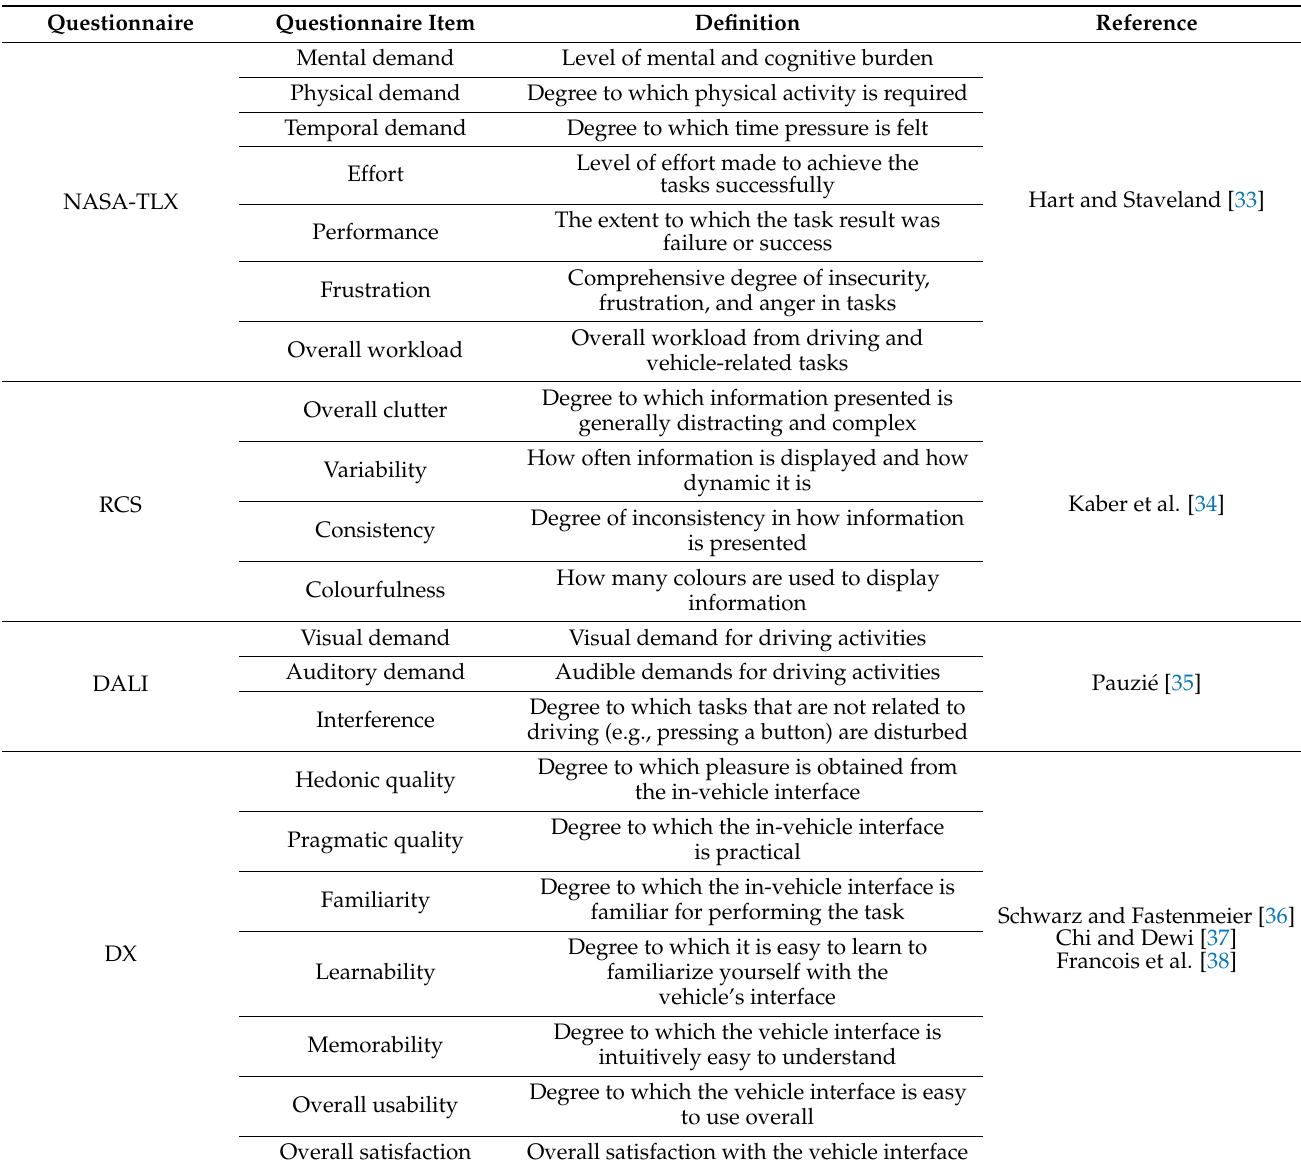
Table 4. Questionnaire